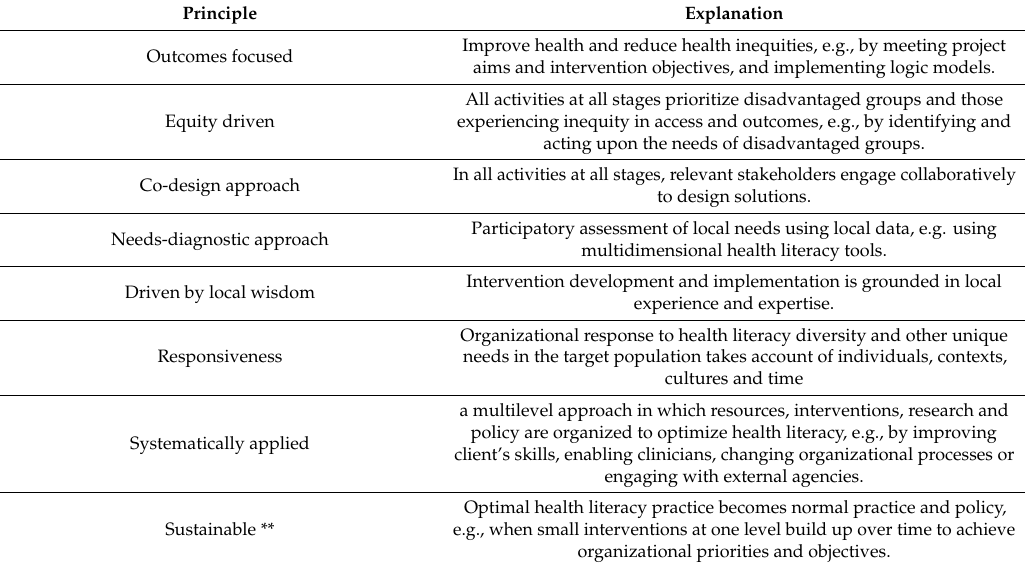
Figure 1. The Ophelia approach in seven steps (adapted from Batterham et al. [7] *).* The steps were adapted in accordance with the steps described in the Ophelia manual [26], e.g., adding step 1 to the original methodology. Table 1. Eight Ophelia principles to guide the development and implementation of interventions (adapted from Beauchamp et al. [11] *).